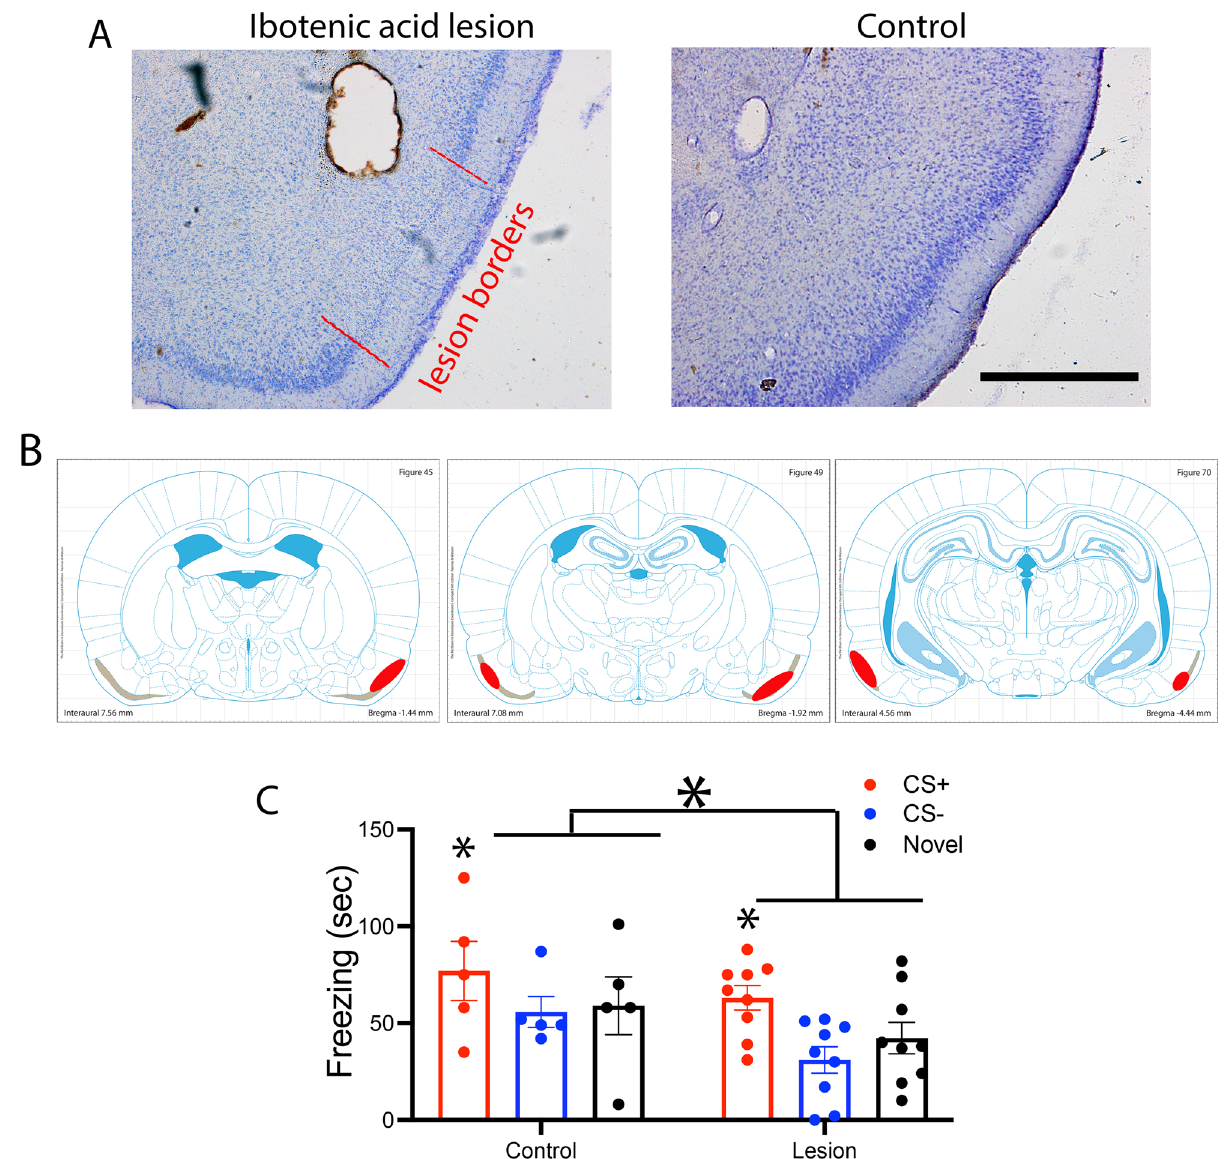
Figure 5. ( A ) Representative ibotenic acid lesion of the pPCX from a single animal and representative control. Ibotenic acid lesion induced cell loss in regions of pPCX layer II are highlighted with red lines. Scale bar = 1 mm. ( B ) Reconstruction of the extent of lesion in one animal. Gray zone is Layer II of the pPCX. Red areas highlight regions of cell loss. Schematic brain images were modified from Paxinos and Watson 77 . ( C ) Animals with partial cell loss in pPCX showed a significant reduction in odor-evoked freezing after odor threat conditioning. Small asterisks signify significantly more freezing to the CS+ than other odors in both the Control and Lesion groups ( p < 0.05). Large asterisk signifies significantly less freezing in the Lesioned group compared to Control (ANOVA main effect of group, p <